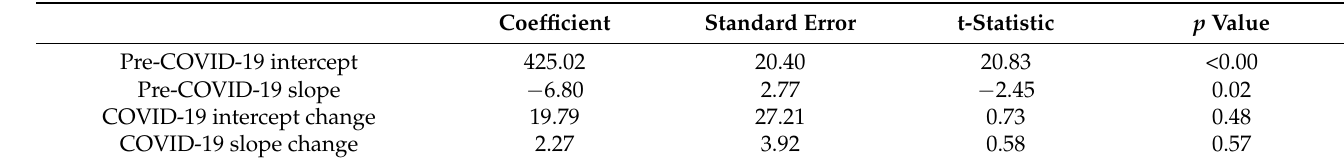
Table 1. Parameter estimates, standard errors, and p values from the segmented regression models predicting the mean monthly number of patients experiencing MHCs who used EMSs.